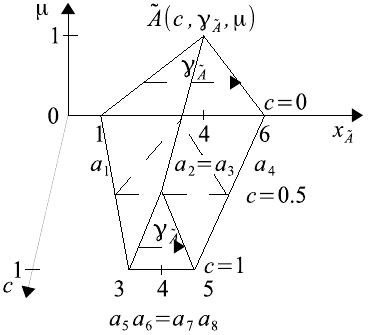
Figure 22. A triangular T2FN ˜ A defined by the Formula (44), shown in 3D